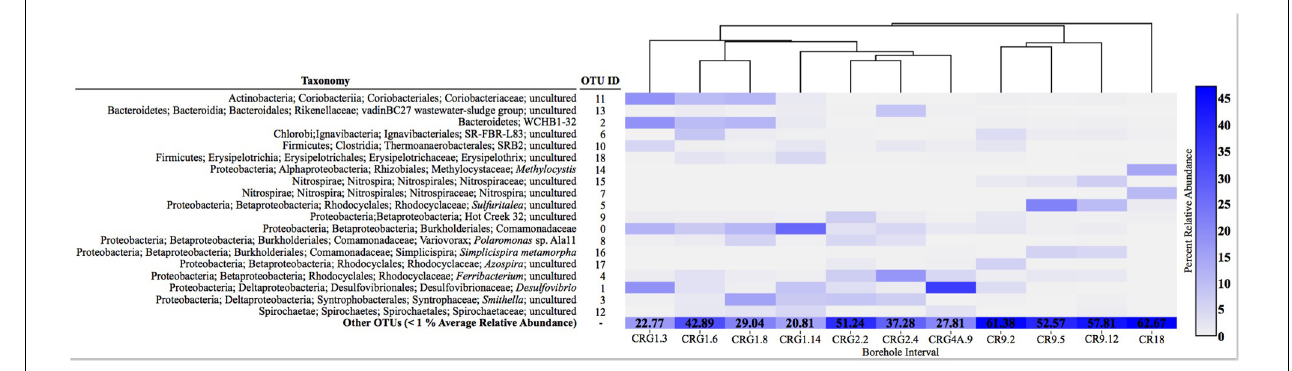
FIGURE 3 | Diagram showing the taxonomic identification of the most abundant operational taxonomic units (OTUs, > 1% average relative abundance) and their relative abundance in each sample (heatmap). The relative abundance of all other OTUs ( < 1% on average) is grouped as “Other OTUs.” with their collective relative abundance (%) denoted in each box. The dendrogram above the samples depicts similarity among the microbial communities based on unweighted UniFrac distances.